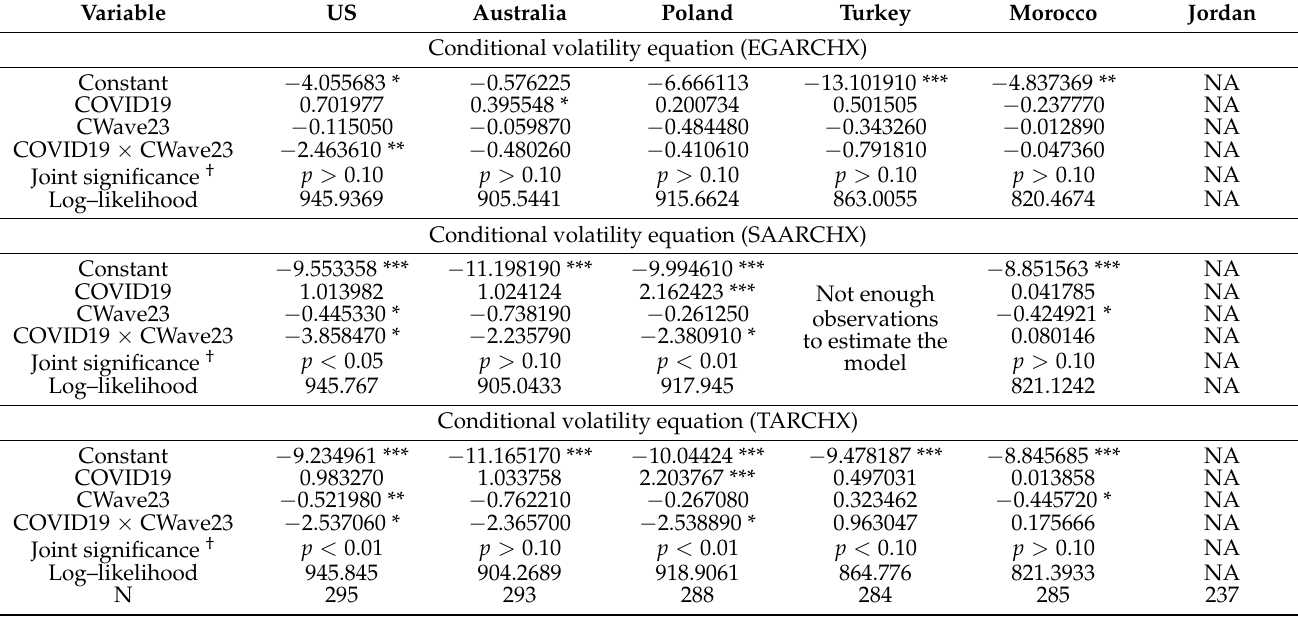
Table 3. Estimates of additional asymmetric GARCH-type